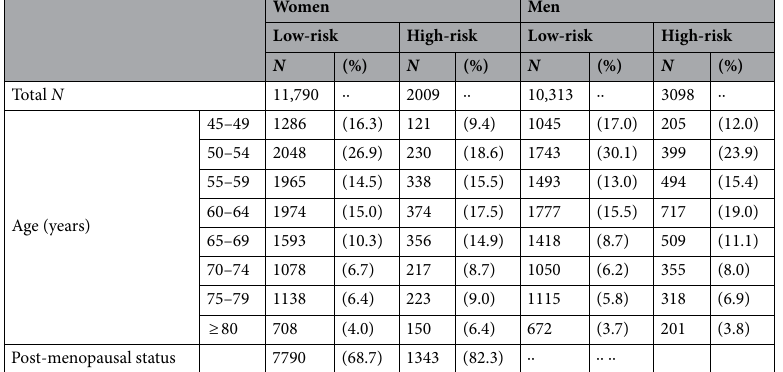
Table 1. Crude number and weighted proportion of women and men in each age and menopausal category, based to their risk of having OSA (low-risk vs high-risk). Low-risk for OSA corresponds to a STOP- Obesity score < 3; High-risk for OSA corresponds to a STOP-Obesity score ≥ 3. Abbreviations: N number of participants, OSA obstructive sleep apnea.